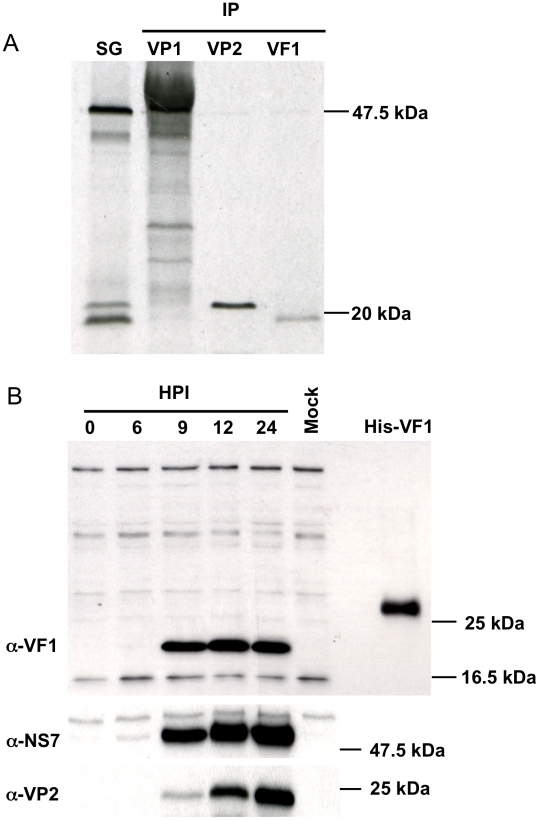

In vitro synthesis of the murine norovirus VF1 protein.(A) Coupled in vitro transcription and translation of a cDNA construct containing the murine norovirus 1 (MNV) sgRNA was performed prior to immunoprecipitation (IP) with polyclonal antisera to VP1, VP2 or VF1. Immunoprecipitated complexes were subsequently resolved by SDS-PAGE (15% polyacrylamide) alongside an aliquot of the complete reaction prior to immunoprecipitation (SG). (B) Western blot analysis indicating VF1 expression during virus high multiplicity infection. RAW264.7 cells were infected with MNV-1 at a MOI of 5 TCID50 per cell. Protein samples were prepared at various times post infections (HPI) and then separated by SDS-PAGE (15% polyacrylamide) prior to immune-blotting with antisera to VF1, NS7 or VP2.